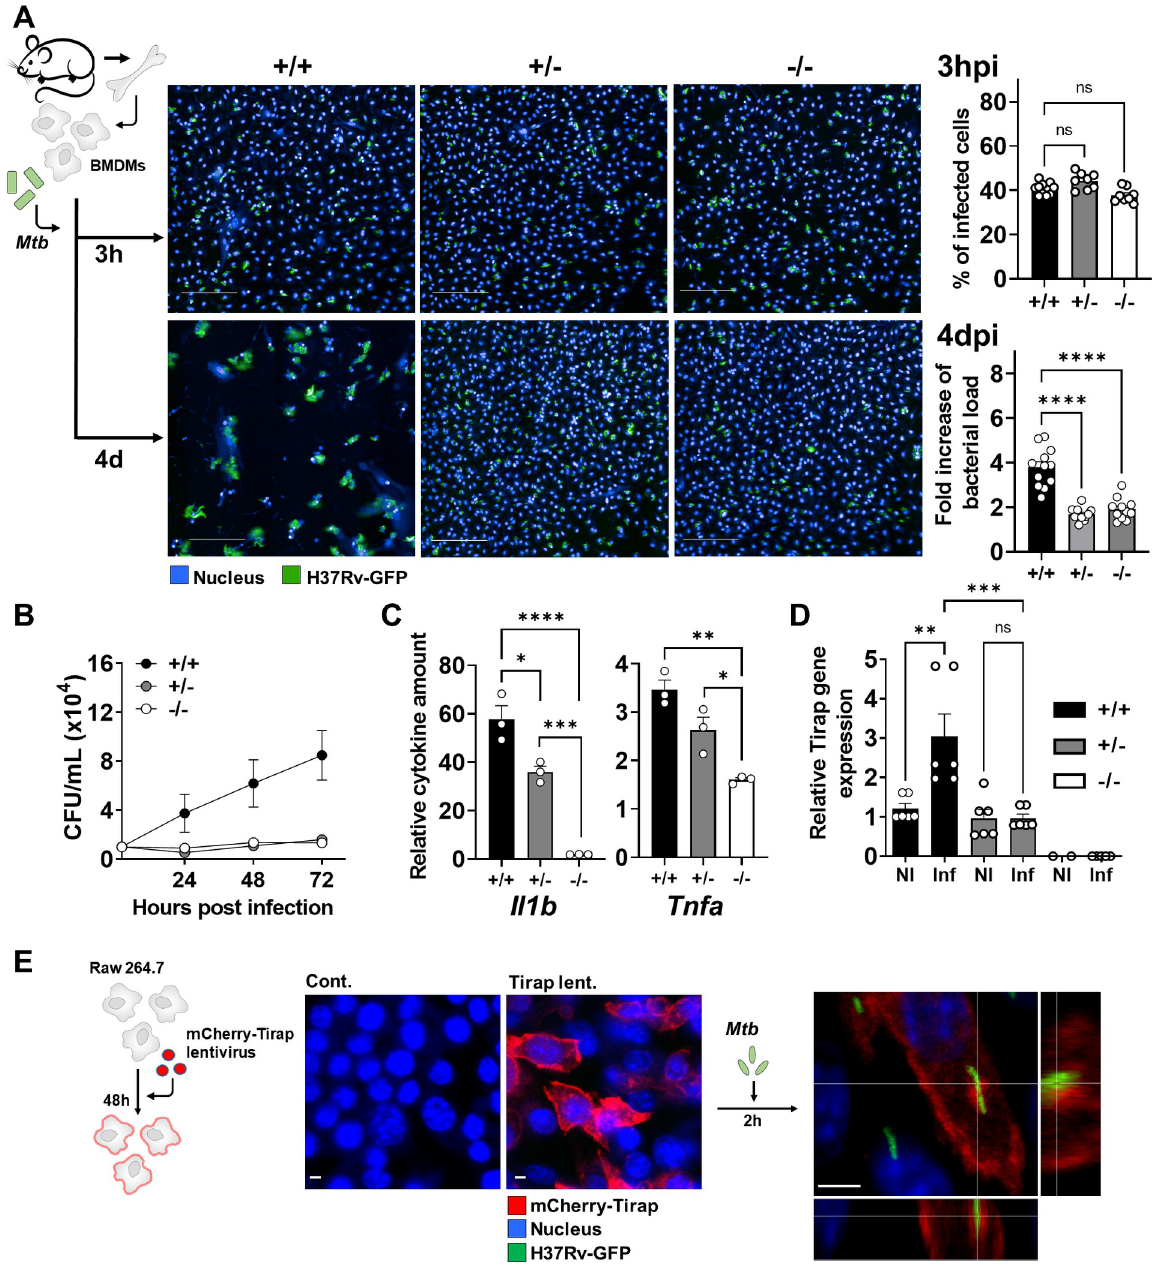
Fig 2. Tirap expression and localization in Mtb-infected BMDMs: Impact on bacterial growth and cytokine expression. ( A ) BMDMs were grown in 384-well plates, infected with Mtb H37Rv-GFP (MOI of 2) and analyzed by automated confocal microscopy. Shown are representative images of Tirap +/+ , Tirap +/- and Tirap -/- BMDMs at 3 hpi (upper panel) and 4 dpi (lower panel). Segmentation algorithms were applied to input images to detect nuclei labeled by Hoechst 33342 (cyan) and the GFP signal of Mtb H37Rv (green) to determine infection rate 3 hpi (upper histogram) and replication fold increase from 3 hpi to 4 dpi (lower histogram). Shown are mean ± SEM of at least 8 analyzed wells per condition of one representative out of three independent experiments. Bar: 50 μ m. ( B ) BMDMs were grown in 24-well plates, infected with Mtb H37Rv (MOI of 2) and lysed at 2, 24, 48 and 72 hpi. Serial dilutions of lysates were plated out to determine bacterial load by counting CFUs. Shown are mean ± SEM of 4 wells per condition of one representative out of two independent experiments. ( C ) Histograms showing relative cytokine amounts in supernatant of infected WT, Tirap +/- and Tirap -/- BMDMs 96 hpi compared to non-infected cells. Shown are mean ± SEM of three infected wells. ( D ) Histogram showing mean ± SEM of relative Tirap gene expression. WT, Tirap +/- and Tirap -/- BMDMs were infected with Mtb H37Rv at MOI of 2 for 3 h. Non-infected (NI) WT cells served as control. Transcription of Tirap was assessed by quantitative RT-PCR and normalized to the expression of Gapdh , used in all samples as a housekeeping gene. ( E ) RAW264.7 cells were transfected with mCherry-Tirap vector expressing lentivirus for 48 h prior to infection with Mtb H37Rv-GFP. Confocal microscopy imaging shows subcellular localization of